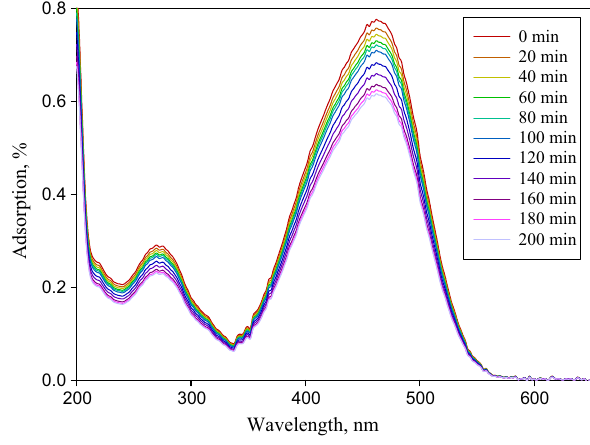
Fig. 4 Adsorption spectrum of reaction system in the absence of ZnO photocatalyst, methyl orange 10 mg L −1 and pH 6